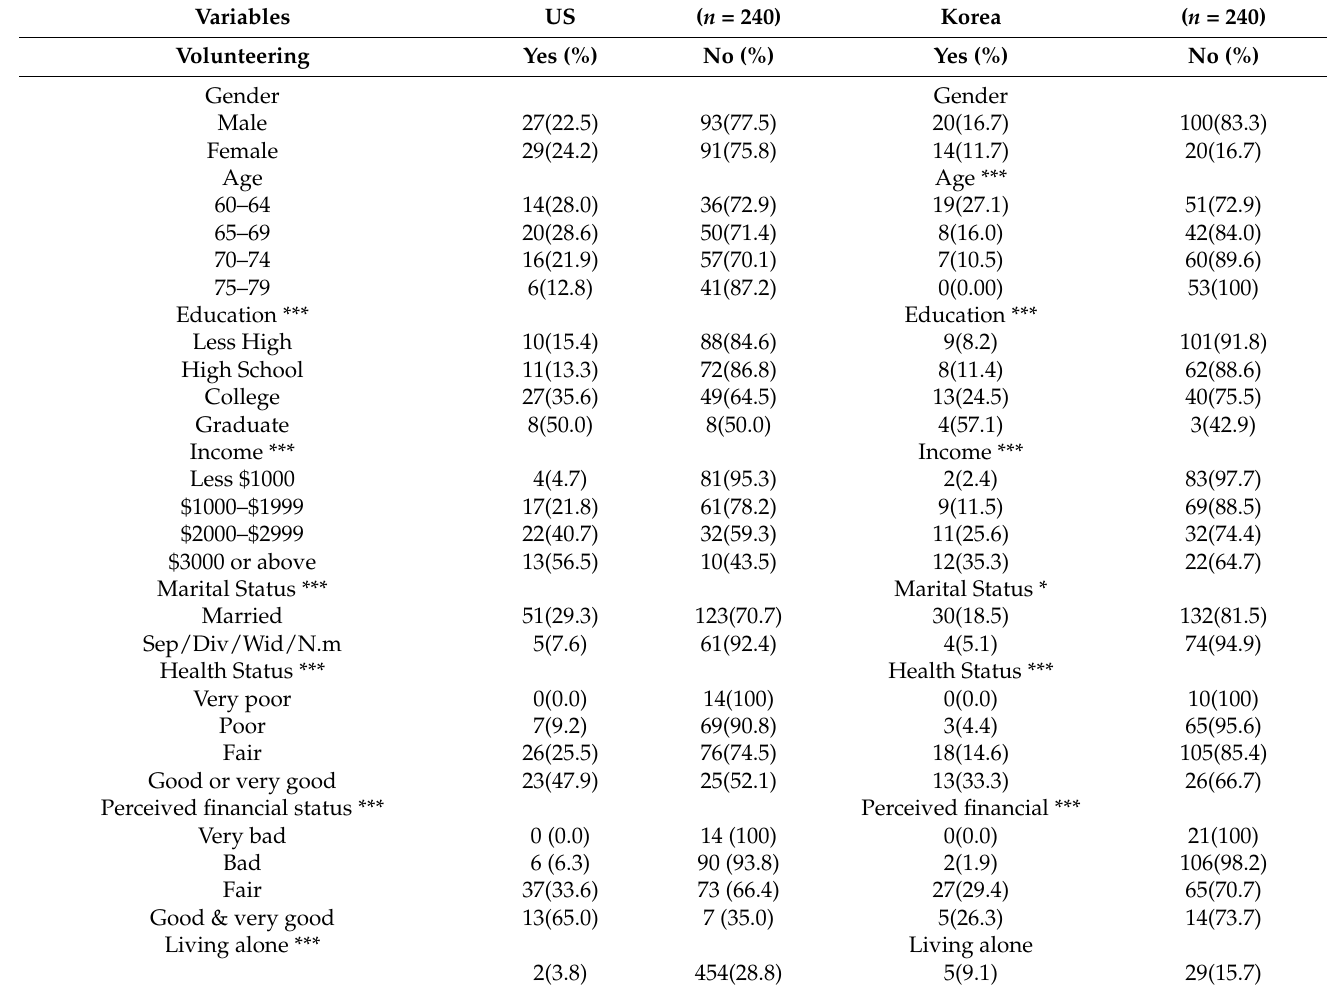
Table 2. Contingency table of various independent variables with volunteering (US: n = 240 & Korea: n =